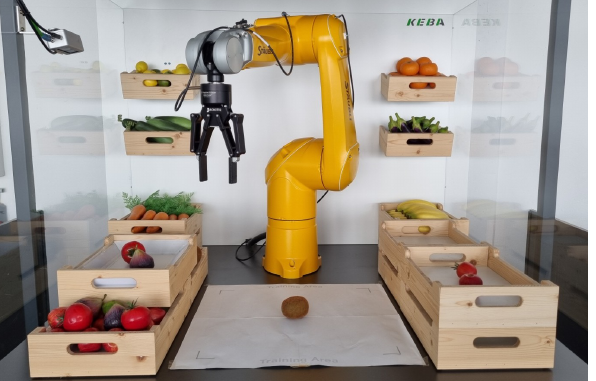
Figure 2. Showcase to demonstrate fast retraining of new object classes: A robot sorting different types of fruits. The left box holds a mixture of different fruits, from which the robot picks up specific ones and transfers them to the correct basket on the right. The new object needs to be placed in the center of the white area by a human operator for the generation of training images. These images are taken by a camera at the robot’s gripper while the robot is moving around the object. (Source: KEBA Group